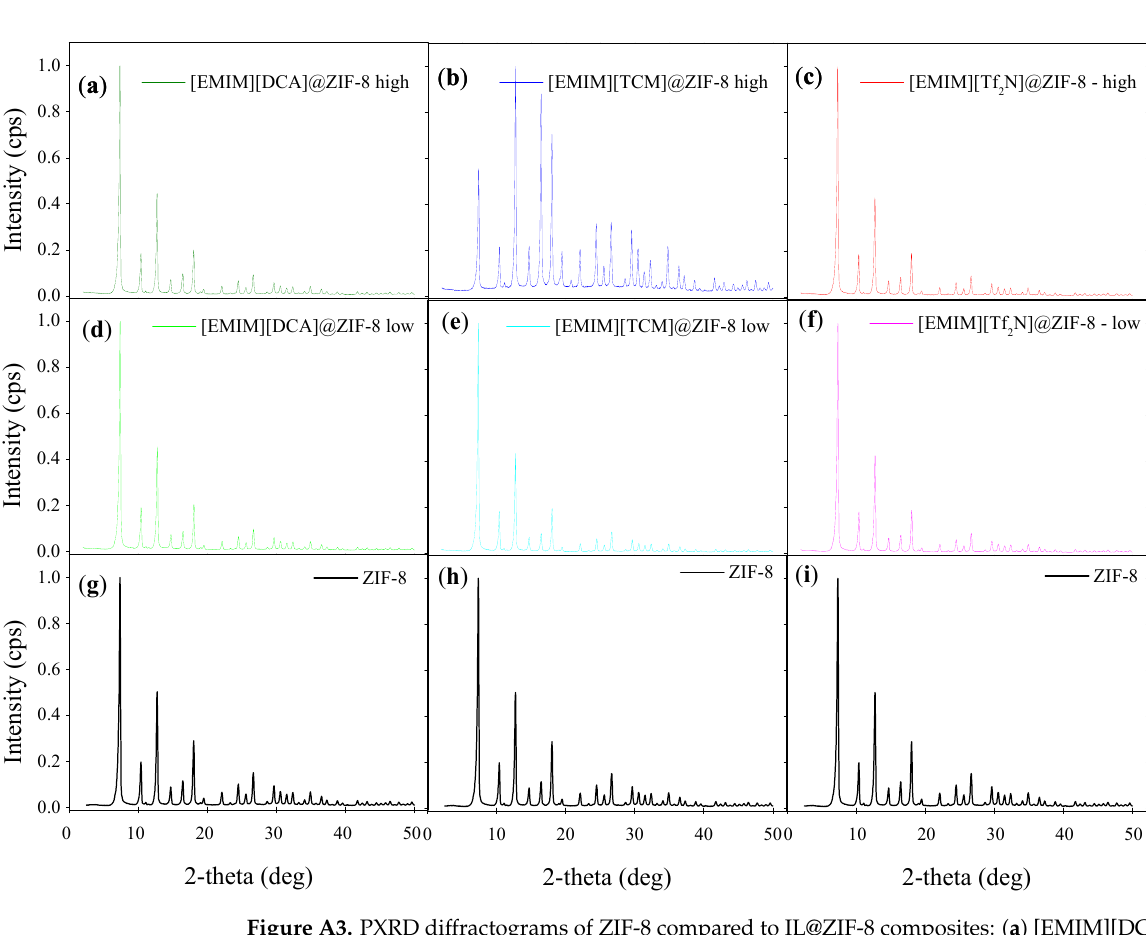
Figure A4. TEM micrographs (10k x magnification) of ( a ) pristine ZIF-8; ( b ) [EMIM][DCA]@ZIF- 8(low); ( c ) [EMIM[TCM]@ZIF-8(low); ( d ) [EMIM][TCM]@ZIF-8(high); ( e ) [EMIM][Tf 2 N]@ZIF- 8(low); and ( f ) [EMIM][Tf 2 N]@ZIF-8(high).